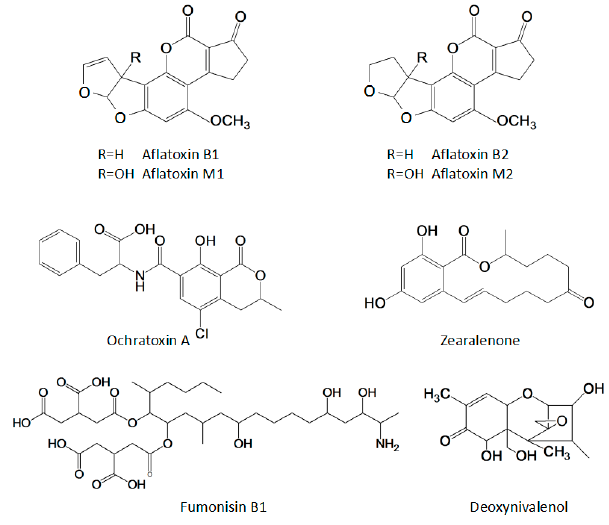
Figure 1. Molecular structures of the main mycotoxins.